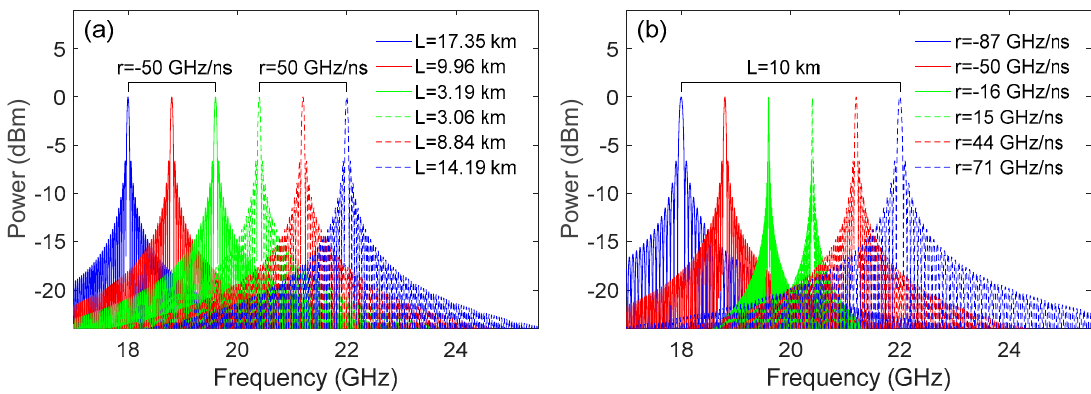
Figure 2. ( a ) The trend of the Sinc function when κ was increasing by the tuning of L and switching the sign of r ; ( b ) The trend of the Sinc function when κ was increasing by the tuning of r with the fixed L .